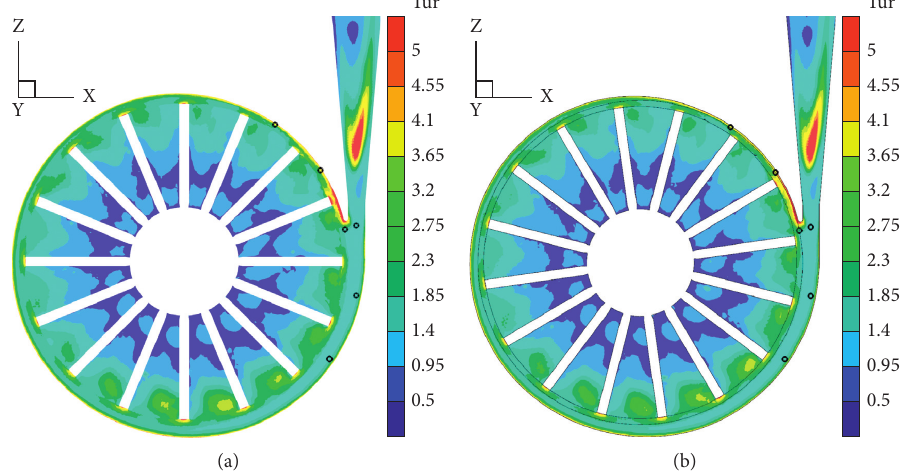
Figure 9: Distribution of turbulence kinetic energy in the central section of the impeller at 1.0 Q pressure pulsation